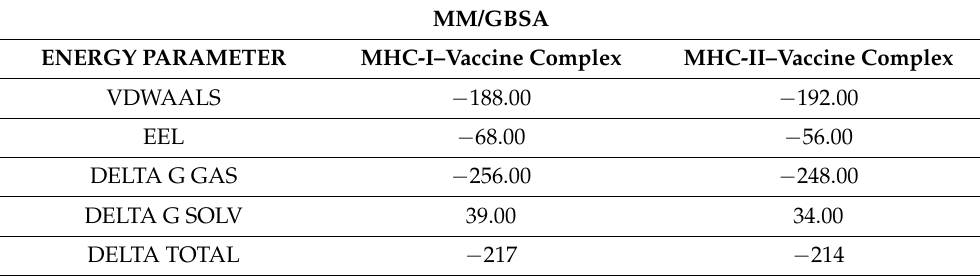
Table 4. MMGB/SA binding free energies estimation.